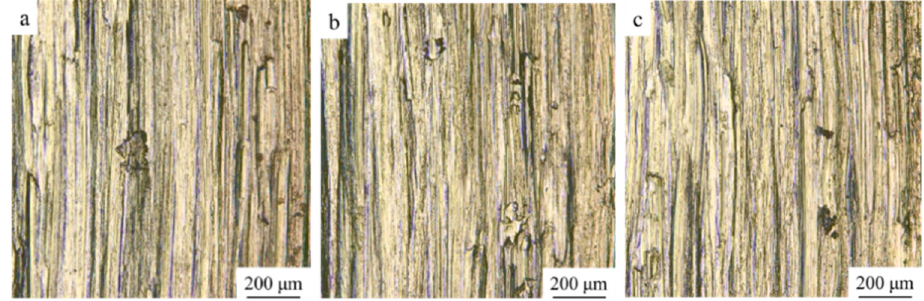
Figure 10. Wear morphology: ( a ) 10% ZrO 2 , ( b ) 20% ZrO 2 , ( c ) 30% ZrO 2.